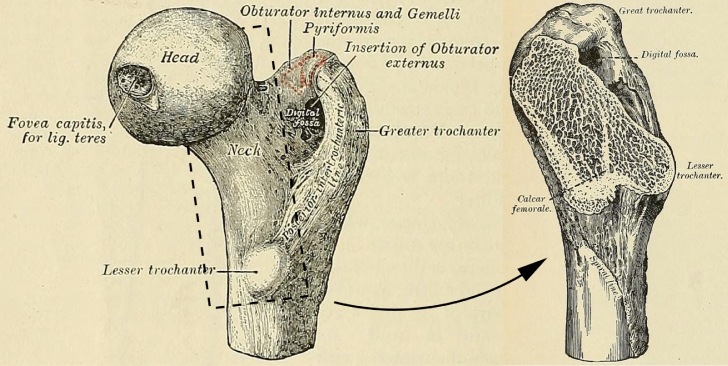
Anatomy of the proximal femur, with section exposing the calcar femorale. Adapted from Gray (1913), Figs. 176 and 182, retrieved 7 June 2017 from archive.org/details/anatomydescript00gray.